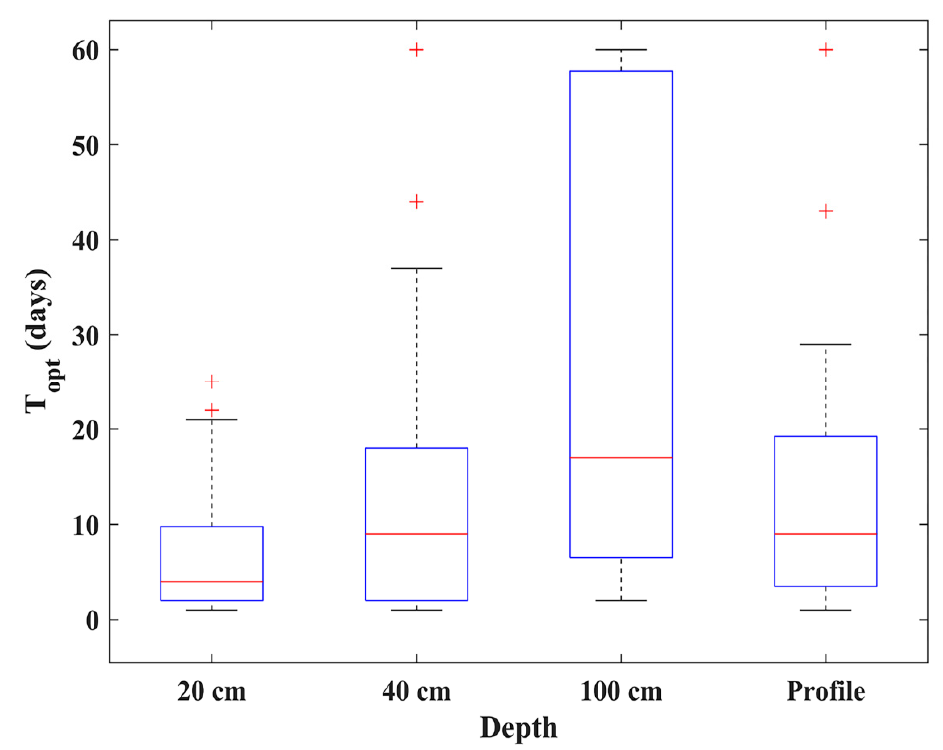
Figure 7. Boxplot of 𝑇 (cid:3042)(cid:3043)(cid:3047) at the depths of 20, 40, 100 cm and for the profile average value for the station-specific T opt . “+” represent outliers of T opt . The T opt represented by each boxplot is divided into six parts by the minimum value, lower quartile (25th percentile), median (50th percentile), upper quartile (75th percentile), maximum value, respectively.